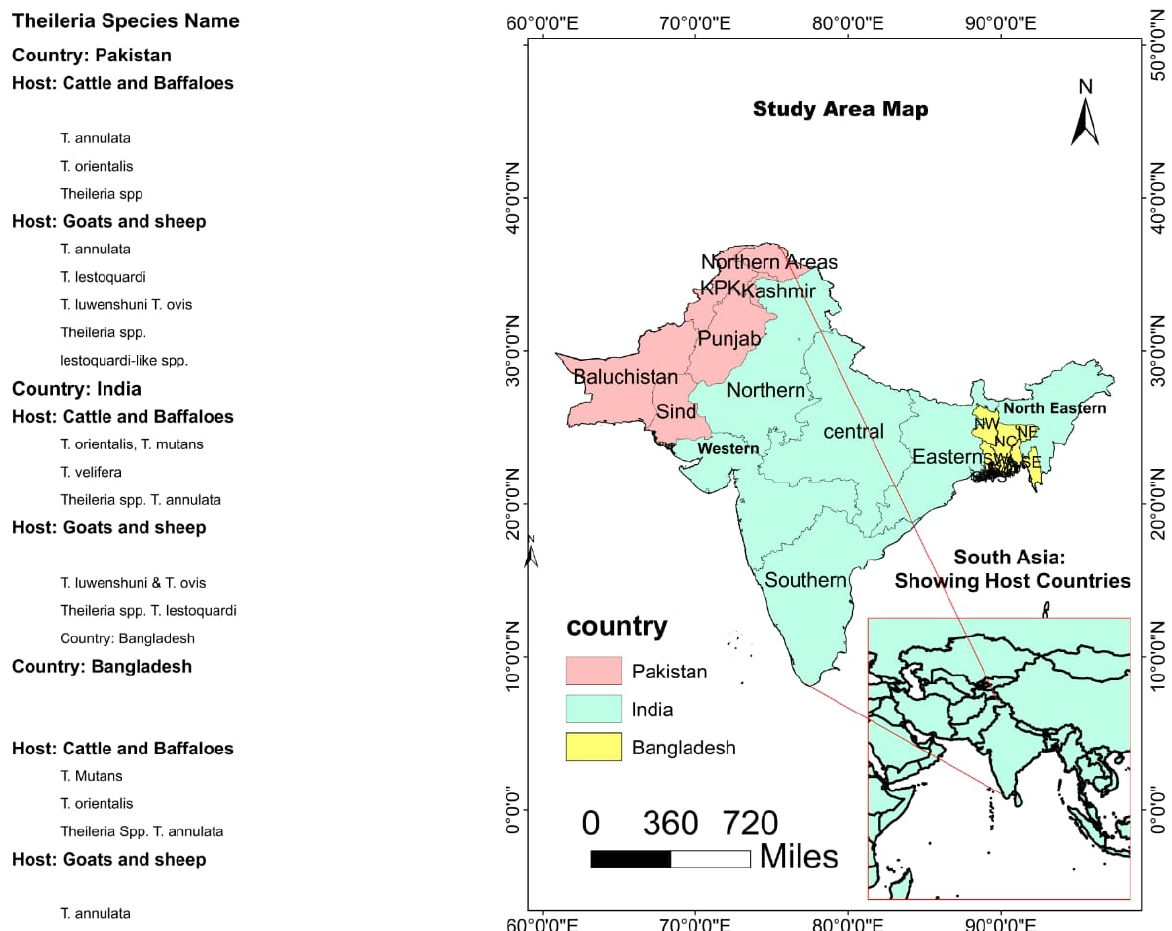
Figure 2. Map showing the location of the study area (India, Pakistan, and Bangladesh) and a list of Theileria Species present in each country.